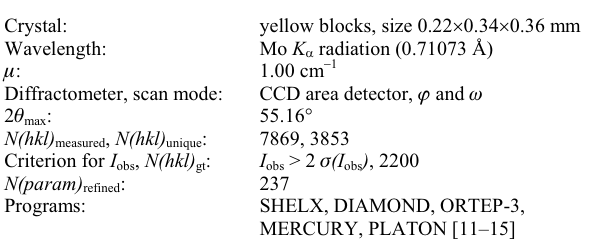
Table 1. Data collection and handling.